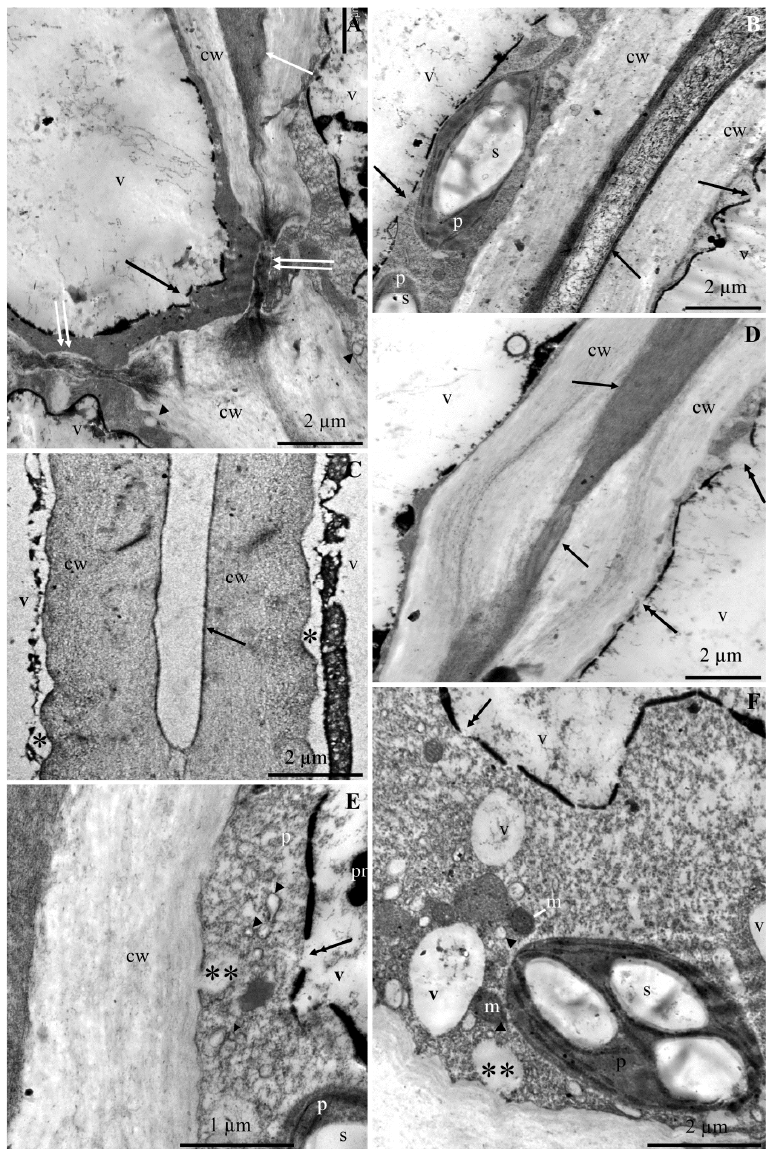
Figure 2. Fragments of the cross sections of hypodermis cells from the apical part of ‘Szampion’ apples from the control treatment. A : cell wall with varied thickness (cw), visible middle lamella (arrow), disappearance of the cell wall between the protoplasts of neighboring cells (two arrows), parietally located cytoplasm, discontinuous and intensively stained tonoplast (double-headed arrow), transport vesicles (arrowhead) near the plasmalemma, vacuole (v). B : cell wall (cw), visible middle lamella with loosened structure (arrow) (dissociation process), tonoplast discontinuity (double-headed arrow), plastids (p) with starch grains (s), tonoplast discontinuity (double-headed arrow), vacuole (v). C : dissociated cell walls (cw), disappearance of the middle lamella (arrow), periplasmic space between the cell wall and cytoplasm (asterisk), parietal cytoplasm, vacuole (v). D : cell wall (cw), varied thickness of the middle lamella (arrow), evaginated and loosened structure of the cell wall at the lamella narrowing, tonoplast discontinuity (double-headed arrow), vacuole (v). E , F : cell wall (cw), visible plasmalemma invaginations (two asterisks), tonoplast discontinuity (two arrows), different- sized transport vesicles (arrowhead), plastid (p) with starch grains (s), mitochondrion (m) (Figure 2F), tonoplast discontinuity (double-headed arrow), vacuole (v) with a flocculent substance in cell sap and a precipitate (pr) (Figure 2E).